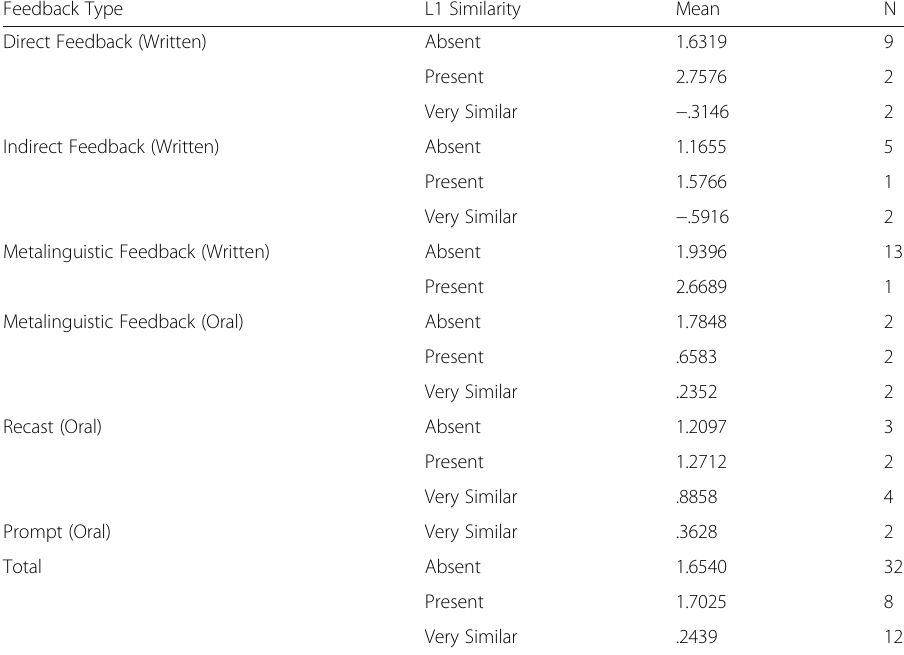
Table 5 Feedback Types by L1 Similarity